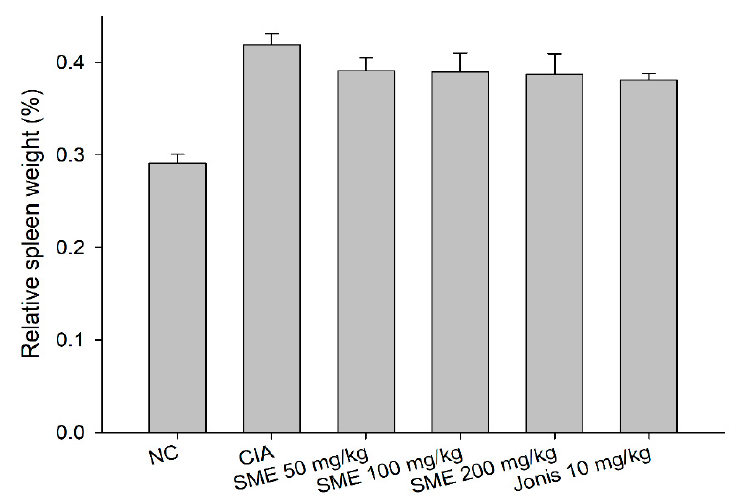
Figure 4. Effects of the Sargassum muticum extract on the relative weight of the spleen. There was no significant difference observed.